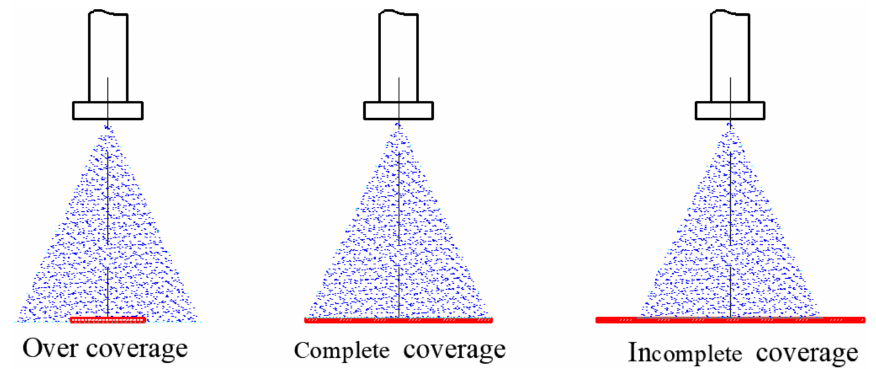
Figure 5. Schematic diagram of Three